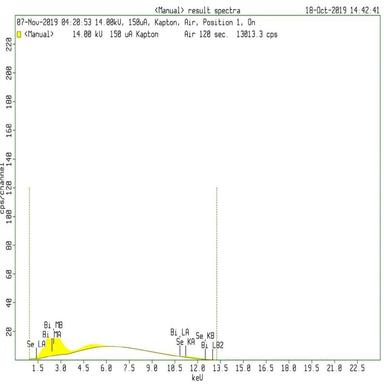
XRF of synthesized Bi2Se3 nanostructures (co-precipitation method with capping).